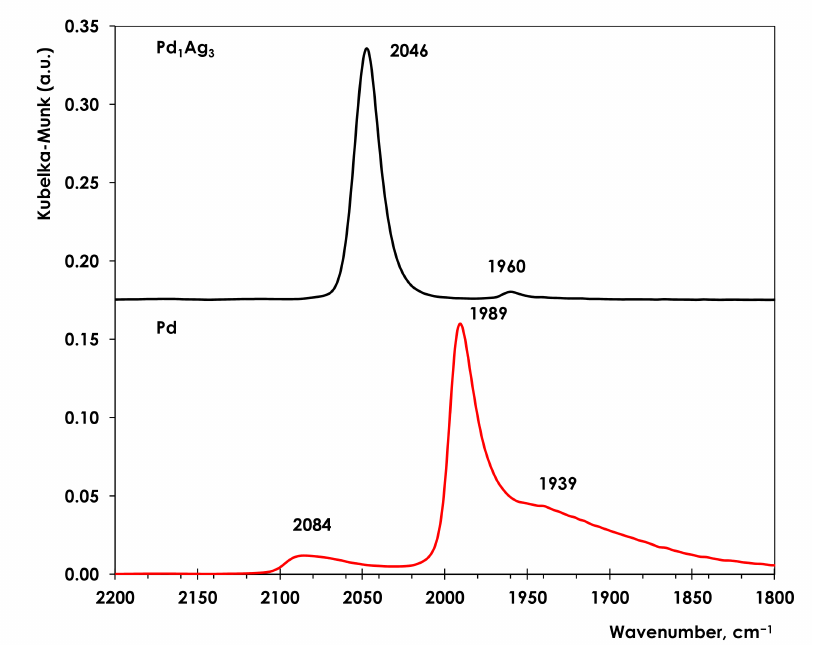
Figure 3. DRIFTS spectra of adsorbed CO on Pd and Pd 1 Ag 3 catalysts. The spectra were collected at 50 ◦ C in 0.5 vol.% CO/He flow (30